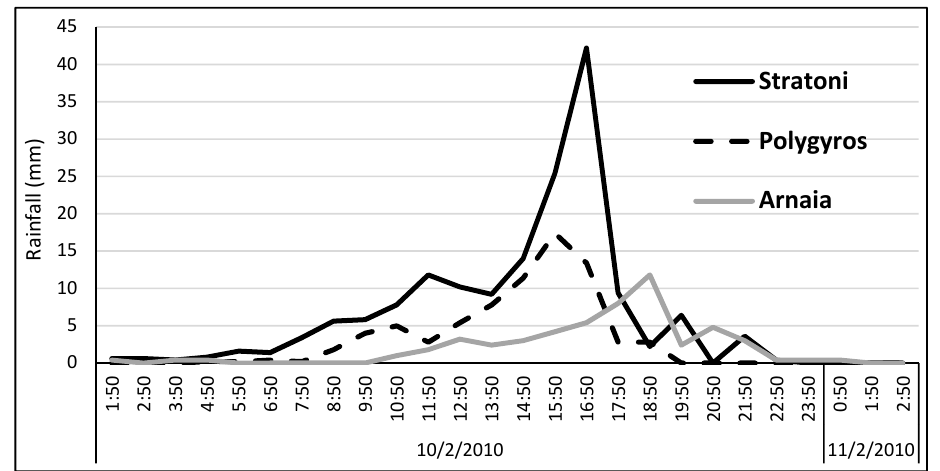
Figure 5. Rainfall intensity at Stratoni, Polygyros, and Arnaia observatories during the February 2010 flood event.